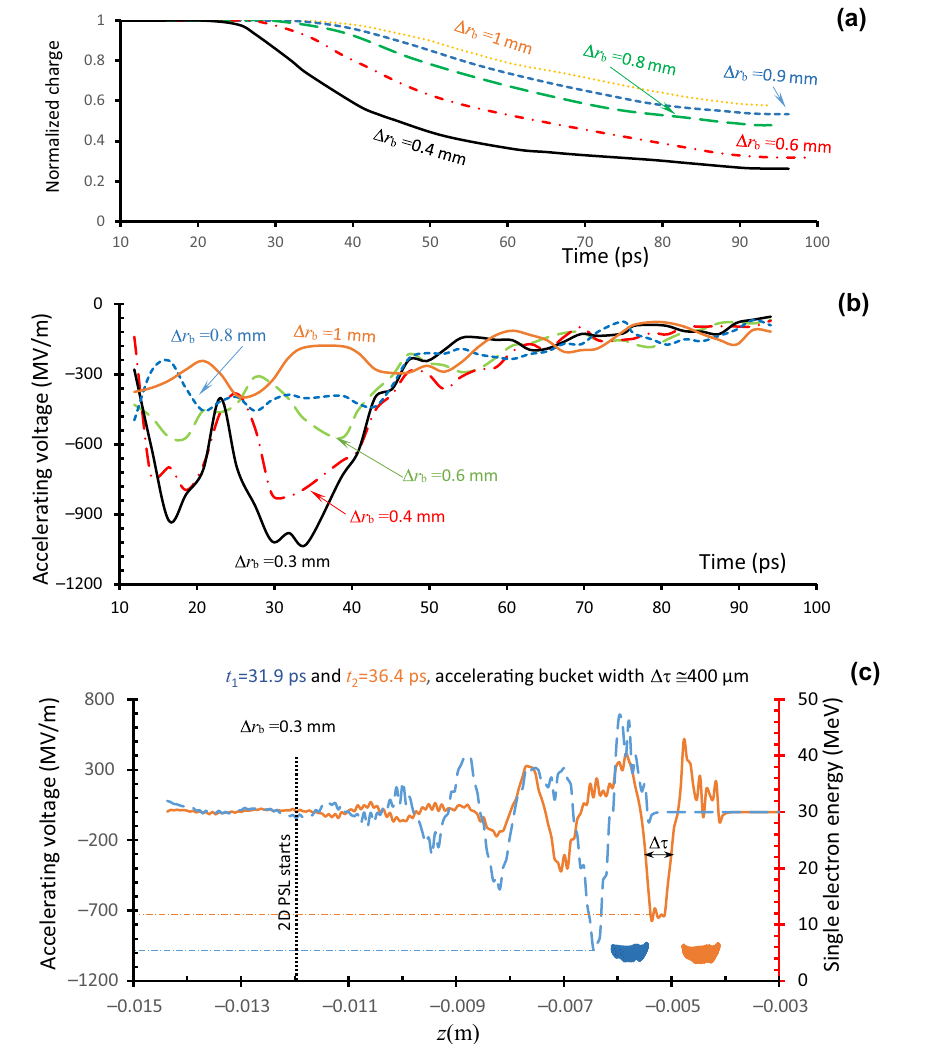
FIG. 3. Results of the numerical studies using 3D PiC code MAGIC . The time dependences of the wakefield driver bunch depletion (a) and the amplitude of the wakefield (b) as the electron bunches propagate through the structure. The results observed for different values of the bunch grating separations Δ r b ¼ 1 mm (dotted line); Δ r b ¼ 0 . 9 mm (short-dashed line); Δ r b ¼ 0 . 8 mm (dashed line); Δ r b ¼ 0 . 6 mm (dash-dotted line); Δ r ¼ 0 . 4 mm (solid line). The graphs in Figs. 3(a)and 3(b)are observed for the same bunches and illustrate b the wakefield amplitude drops in all cases at approximately 50 ps indicating that electron loss and radial dispersion of the bunch are responsible for the amplitude decay. (c) The dependence of the amplitude of the E z field component of the wakefield inside the periodic structure [waveform (left axis)] taken at two different times t 1 ¼ 31 . 9 ps (dashed blue line) and t 2 ¼ 36 . 4 ps (solid orange line) induced by the high intensity (20 nC, 2 ps, injected bunch CM energy 7 MeV) electron bunch which positions at different times, in respect to the wakefield, are also shown (solid blue/orange dots). The electron energy distribution shown on the right axis of the